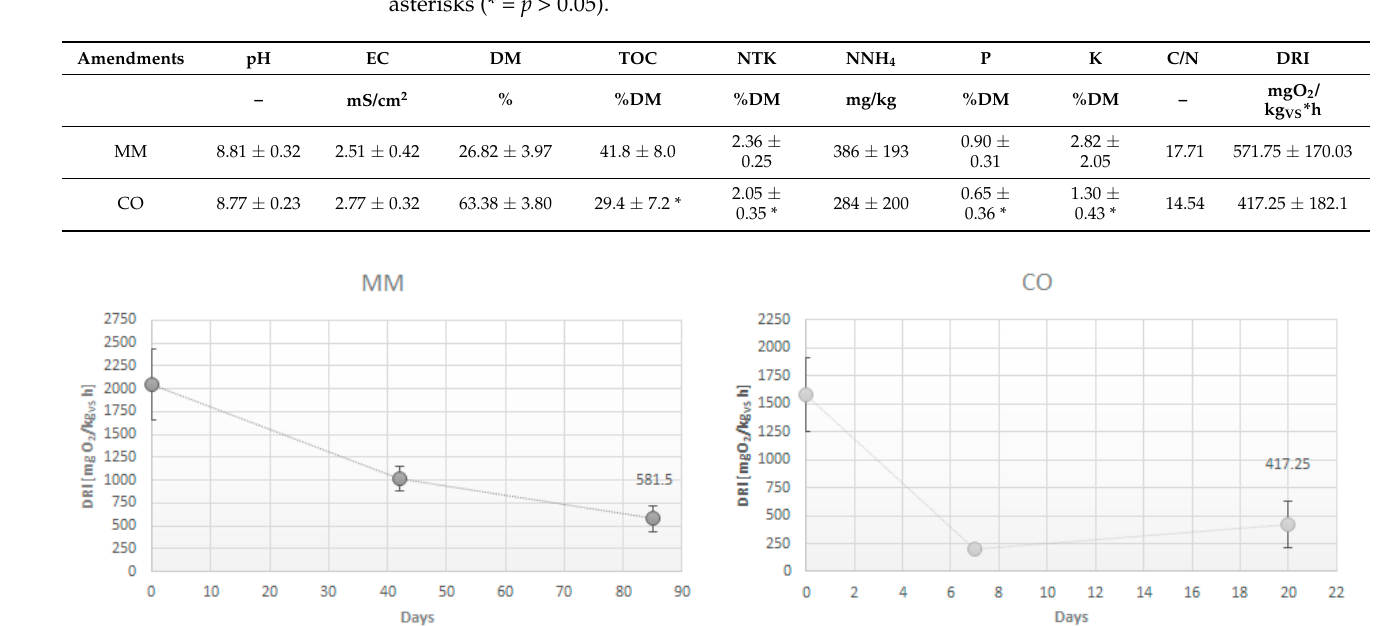
Table 1. Amendments characterization. The significantly different means are identified through asterisks (* = p > 0.05).